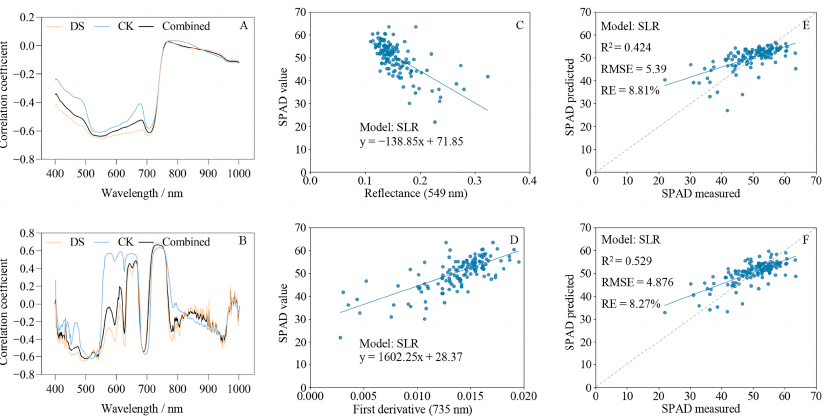
Figure 3. Correlation analysis and fitting results between leaf hyperspectral and SPAD values. ( A , B ) Correlations of spectral reflectance and the first derivative with SPAD values; ( C , D ) simple linear regression (SLR) analysis based on spectral reflectance at 549 nm and the spectral first derivative at 735 nm; ( E , F ) fitting results of predicted and measured values of SPAD based on reflectance at 549 nm and the first derivative at 735 nm. The gray dotted line is the 1:1 fit line between the predicted and measured values. Pearson correlation analysis of hyperspectral reflectance and first derivatives with SPAD values in CK, DS, and combined data sets was performed using Prism 9. Python 3.6 was used for SLR analysis of the data. CK, control; DS, drought stress; combined, all